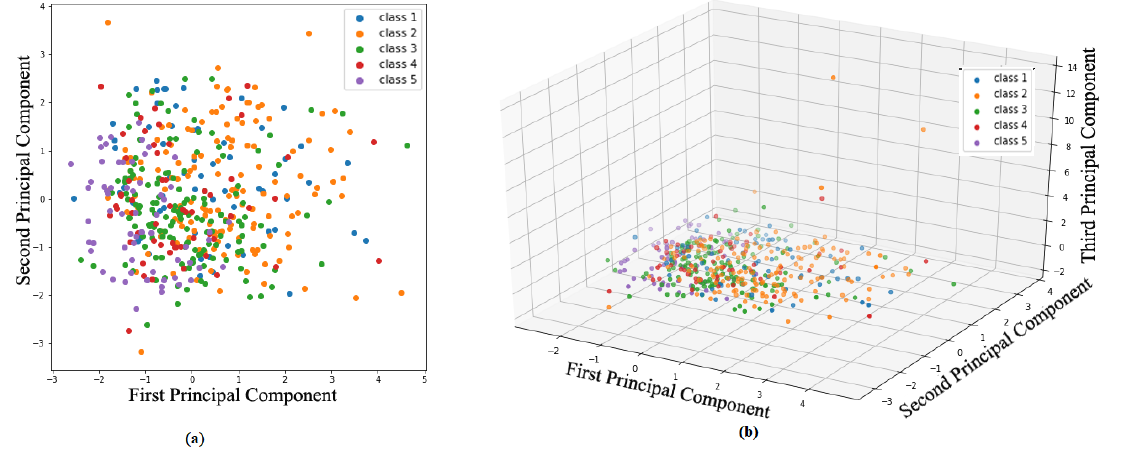
Figure 5. ( a ) 2D and ( b ) 3D visualization of dataset using PCA